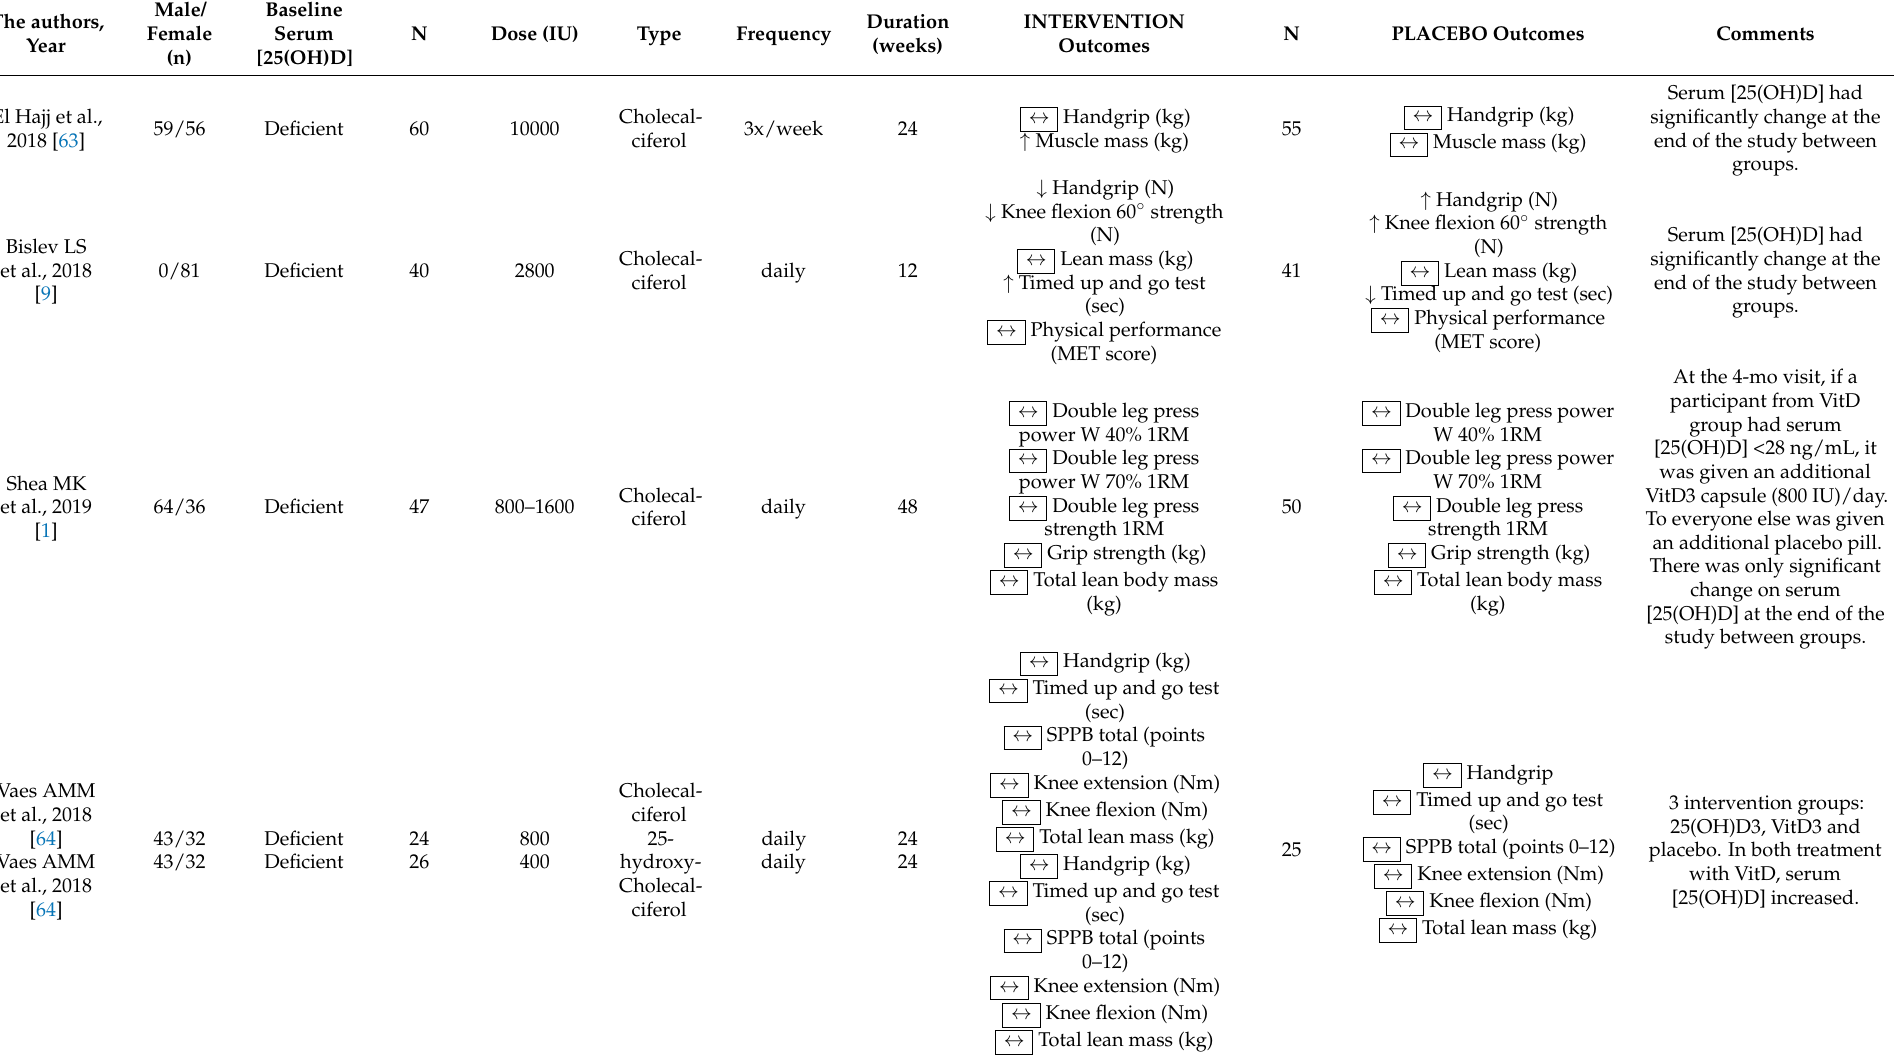
Table 3. Overview of the effects of vitamin D (VitD) in skeletal muscle in an aging population ( n =